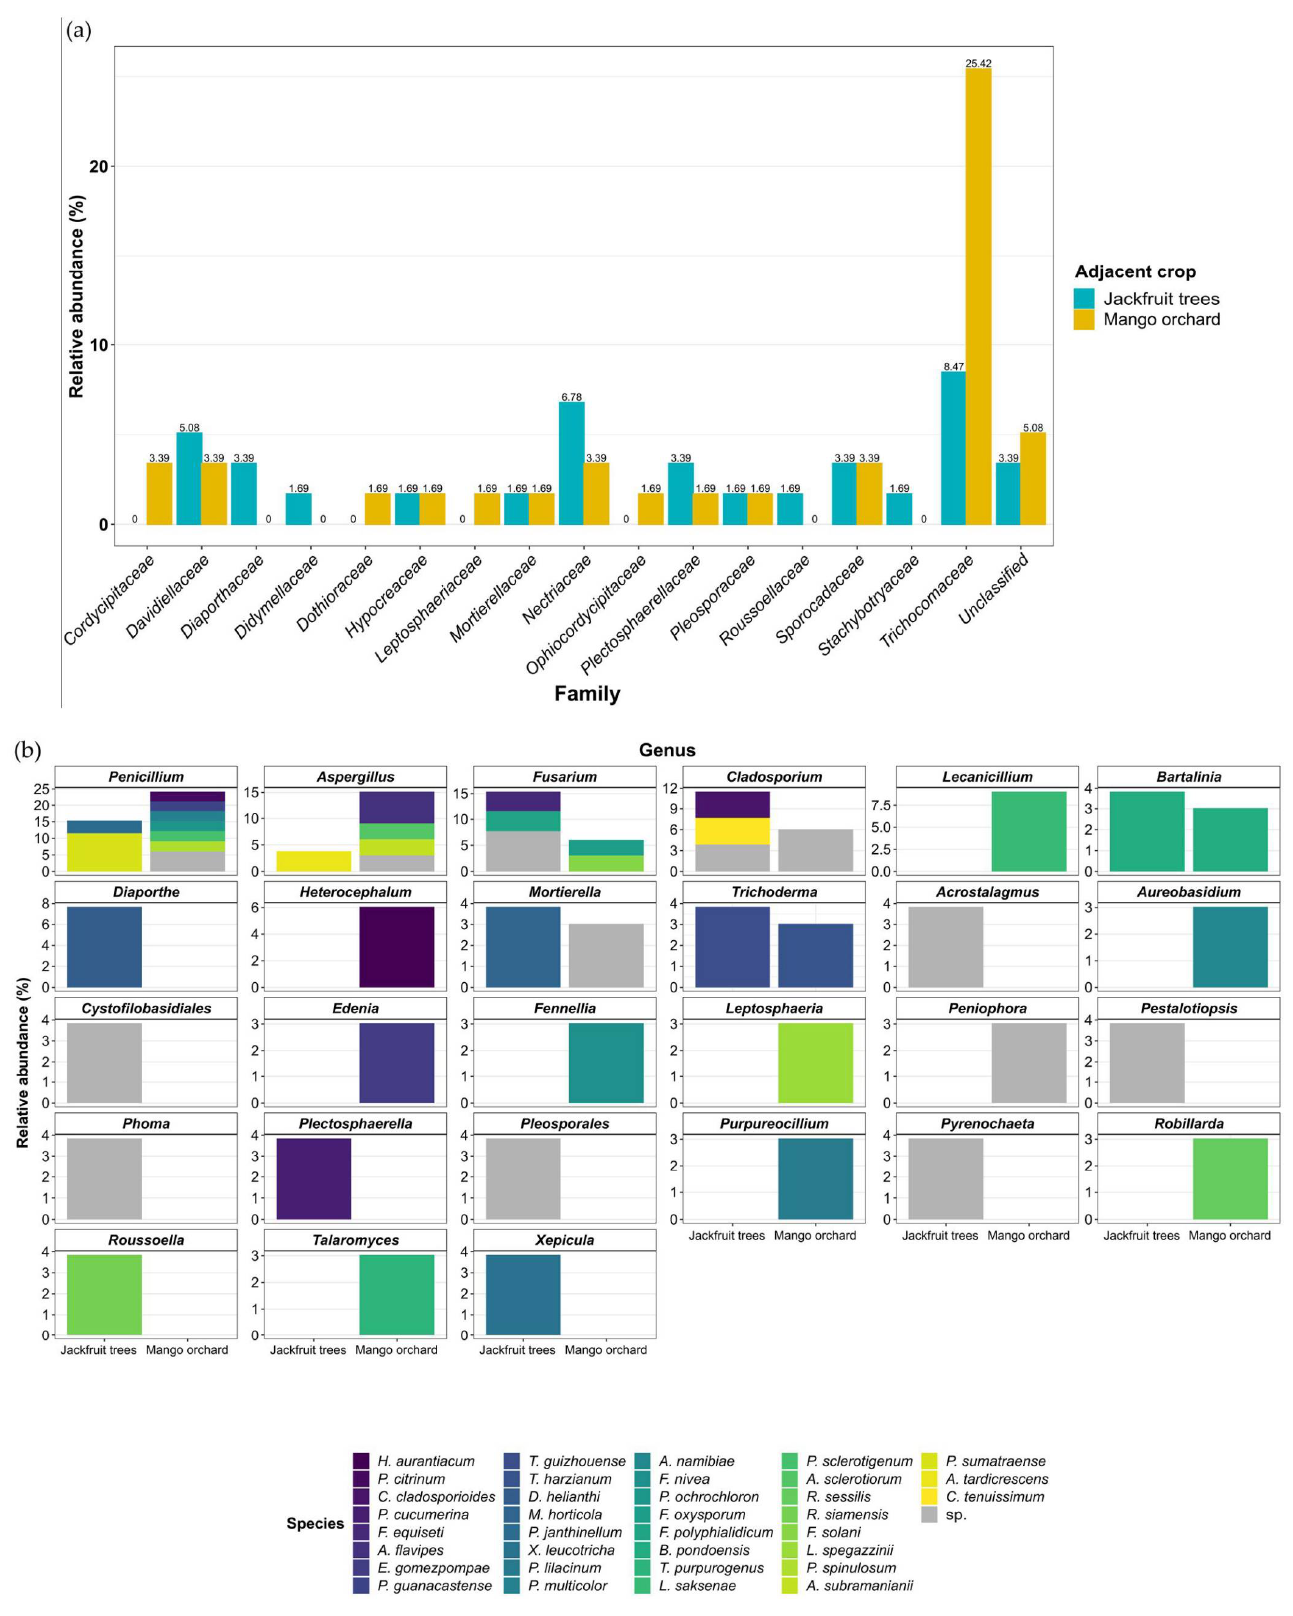
Figure 9. Relative abundances of fungal isolates identified from soil sampled on either side of the pineapple plots (jackfruit trees or mango orchard) at (a) family, (b) genus, and species taxonomic levels.